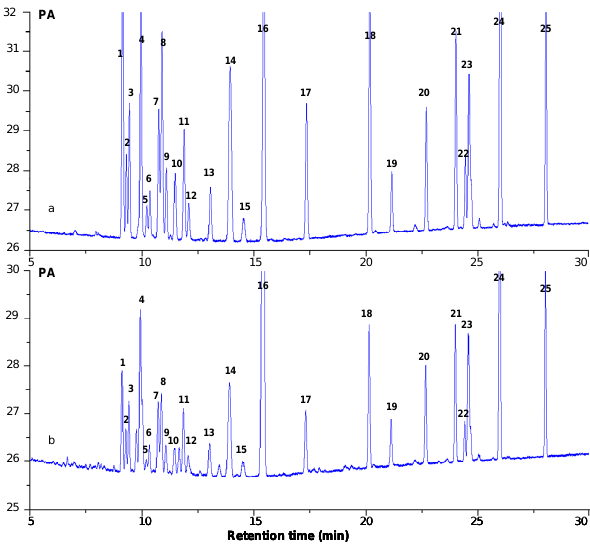
Fig. 2. Gas chromatograms of TMS derivatives of monosaccha- rides. (a) a standard mixture; (b) a hydrolysate from the Pearl River Estuary sediment. Twenty five peaks are identified, and the peaks with “*” are isomers used for quantification: 1. LYX1*; 2. ARA1; 3. ARA2*; 4. LYX2, RHA1, XYL1; 5. RIB1; 6.